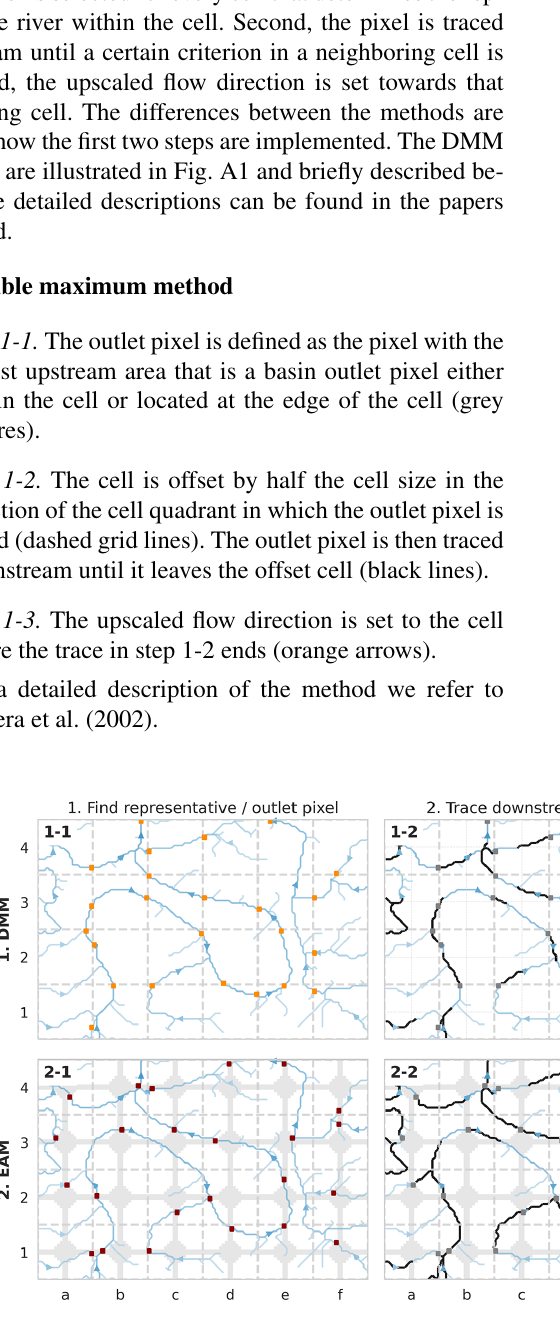
Figure A1. Visual explanation of the double maximum method (DMM; first row) and effective area method (EAM; second row). The target- resolution grid (grey lines) and fine-resolution upstream area map (blue colors) are shown in all plots. The representative (EAM) or outlet (DMM) pixels (squares) are traced downstream until a criterion in a neighboring cell is met (black lines), and the upscaled flow directions are set (orange